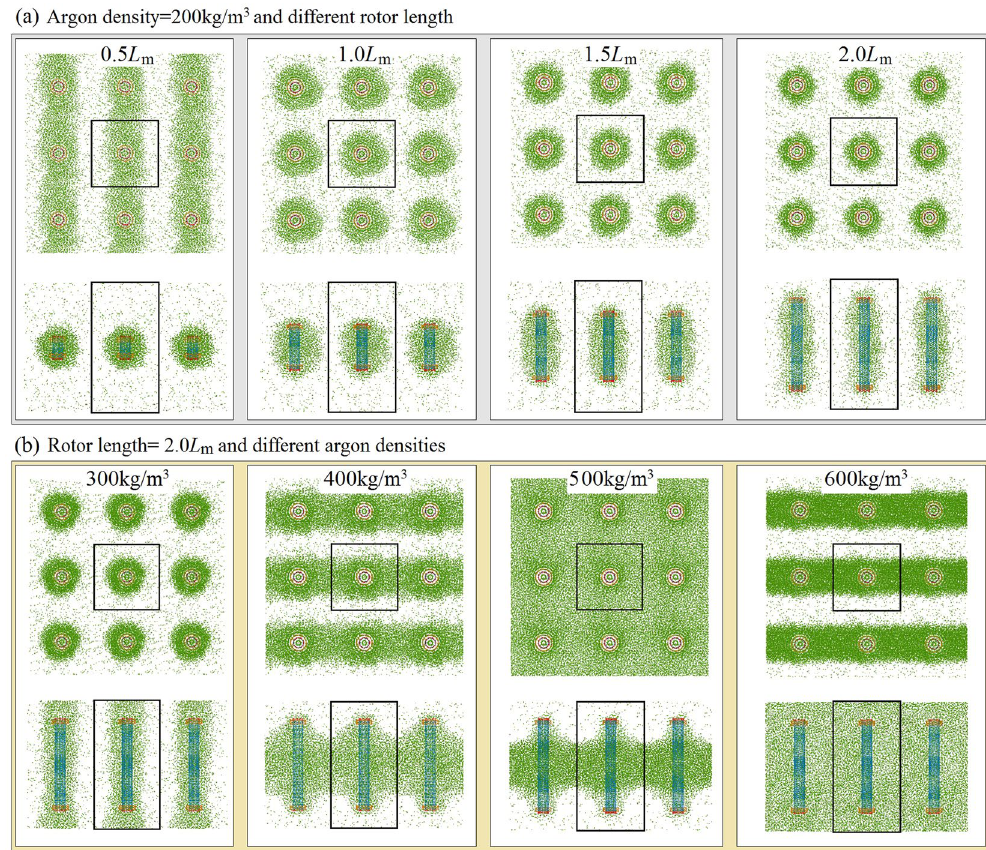
Figure 12. Stable states of simulation boxes in which nanomotors are surrounded by argon atoms. ( a ) In boxes with the same argon density, the rotor lengths differ. ( b ) For the same rotor in the boxes with different argon